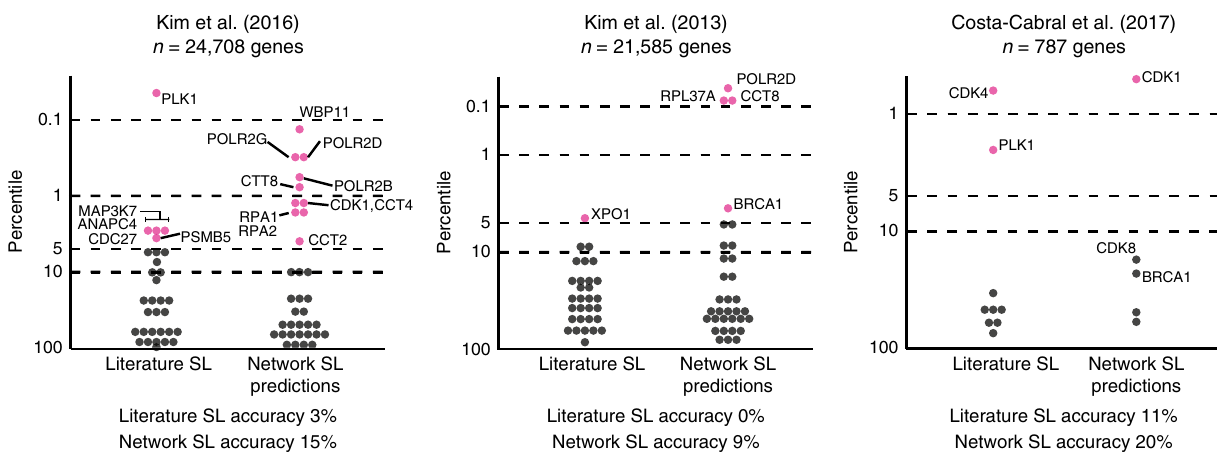
Fig. 2 Comparison of genes in KRAS synthetic lethal networks and previously published KRAS synthetic lethals with held-out studies. A total of 105 predicted KRAS synthetic lethal network genes and 26 previously published KRAS synthetic lethals were evaluated using data from Kim et al. 8 , Kim et al. 9 , and Costa-Cabral et al 7 – 9 . Genes in each study were ranked into percentiles based on the difference in proliferation after knockdown in KRAS-mutant versus wild-type cell lines. The lower the percentile the more evidence for KRAS-speci fi c synthetic lethality. Accuracy calculated as the number of genes in the top 5% (pink dots) out of all the tested genes per category. The number of genes tested in each study, n